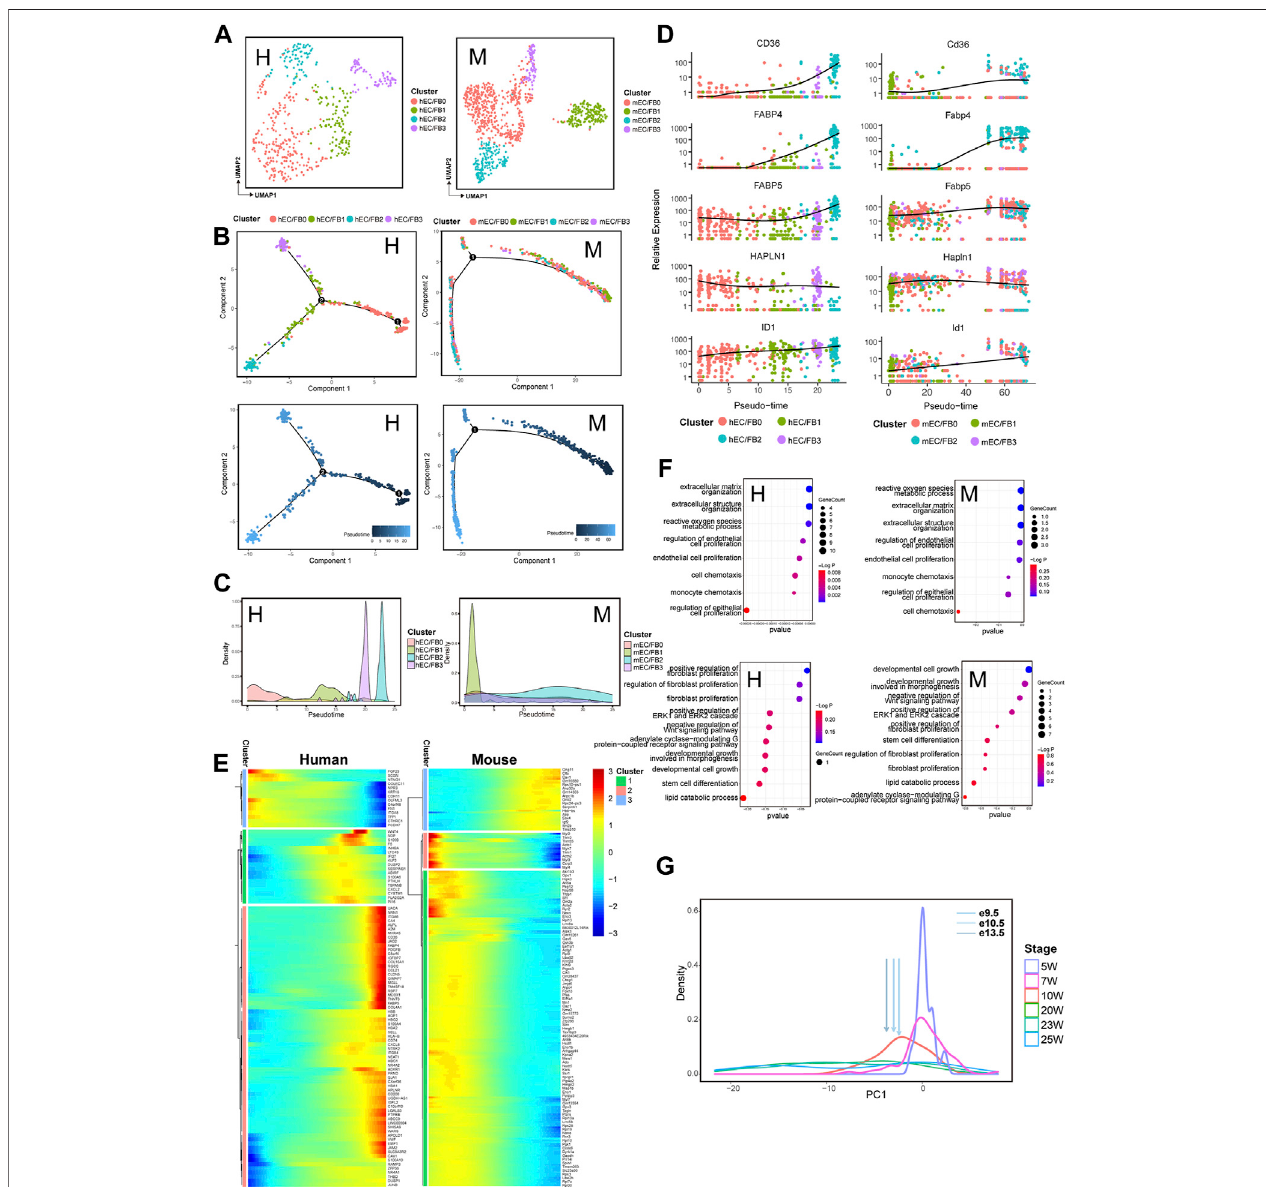
FIGURE5| Transcriptomicdynamicsofendothelialcells/ fi broblastsduringhumanandmouseheartdevelopment(human:H,left;mouse:M,right). (A) UMAPplots showing the subpopulations of human (H) and mouse (M) endothelial cells/ fi broblasts. (B) Pseudotemporal trajectory of EC/FB subpopulations constructed by Monocle2.Upper:coloredbyEC/FBsubpopulations;Lower:coloredbypseudotimevalues,withthevaluerangingfromsmalltolargerepresentingthestarttotheendof the developmental process. (C) Density plot of the distribution of EC/FB subpopulations along the trajectory. (D) Dot plots showing the expression of genes conserved along the trajectory in two species. (E) Heatmap showing the expression pattern of endothelial cells/ fi broblasts along the developmental trajectory. (F) GO enrichmentanalysis(BP)ofthegenesinendothelialcells/ fi broblasts withdifferentexpression patterns alongthetrajectorybetweentwospecies. (G) PCA-baseddensity plot depicting the proportion of hECs/FBs at various time points, showing a considerable overlap in temporal development from 5 W to 24 W. The arrows represent the mean expression of different developmental stages of mouse